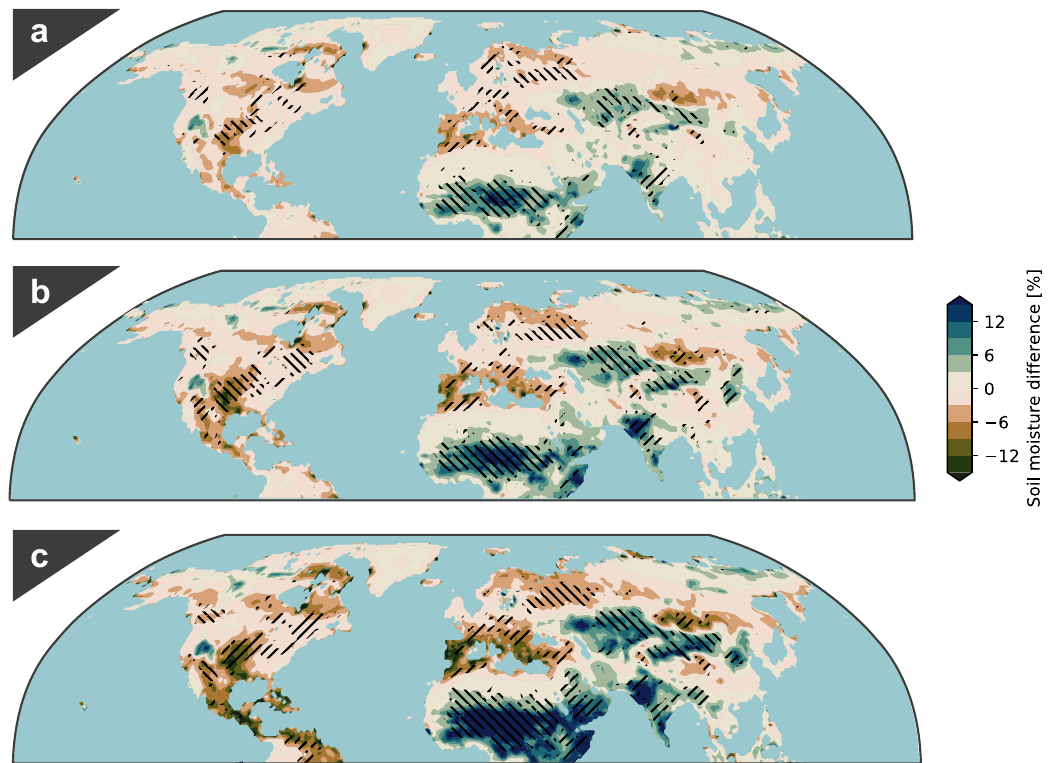
Fig. 9 Averaged anomalies of summer soil moisture (entire column) under SSP1-2.6, SSP2-4.5, and SSP5-8.5. a – c Averaged anomalies of summer soil moisture under SSP1-2.6 ( a ) and SSP2-4.5 ( b ) and SSP5-8.5 ( c ) in the Northern Hemisphere for the period 2071 – 2100 relative to the baseline period of 1971 – 2000. The hatched areas indicate areas where 10 of the 11 CMIP6 models show the same sign of change (data from the AWI-CM-1-1-MR model are not used in this fi gure because the required variable does not exist).